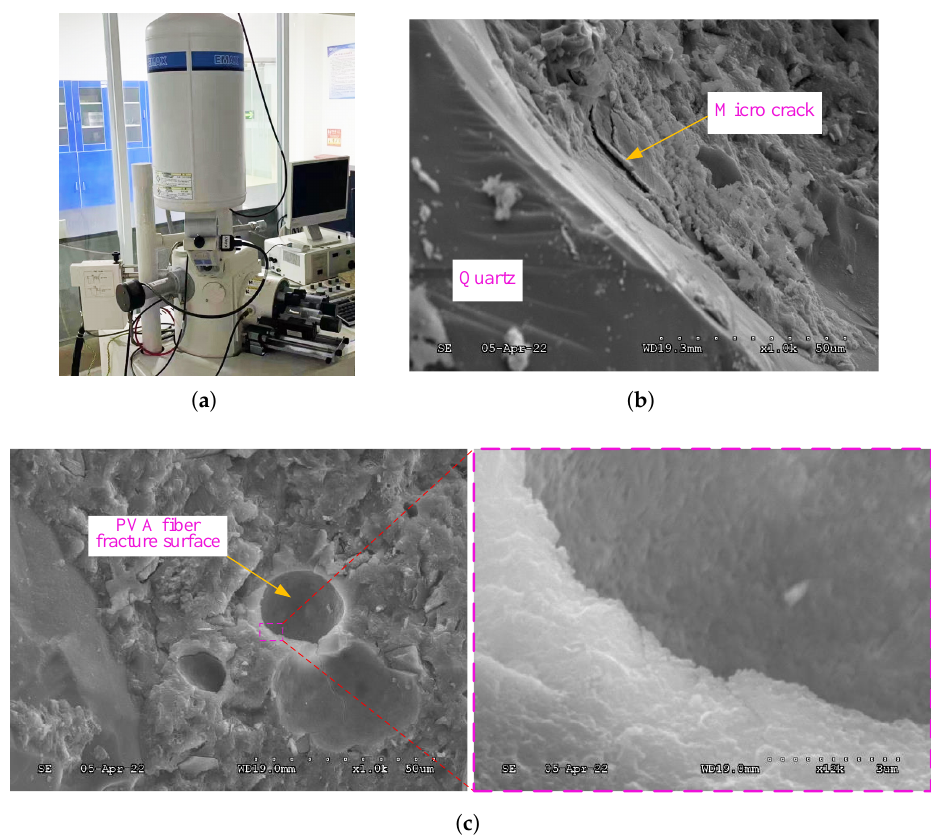
Figure 11. SEM micrographs of the fracture surfaces in the broken UHPC-PVA beams. ( a ) SEM; ( b ) A SEM micrograph near a quartz granule; ( c ) A SEM micrograph near a PVA